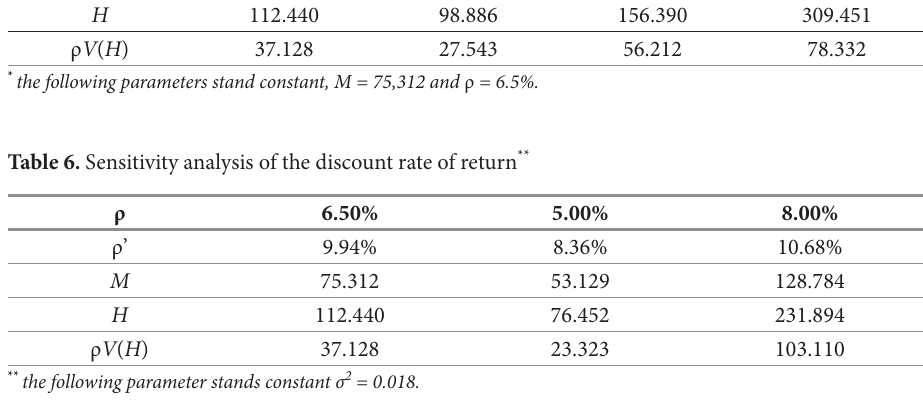
σ 0.134 0.100 0.150 0.200 σ 2 0.0018 0.0100 0.0225 0.4000 ρ’ 9.81% 8.07% 10.38% 12.23% Η 112.440 98.886 156.390 309.451 37.128 27.543 56.212